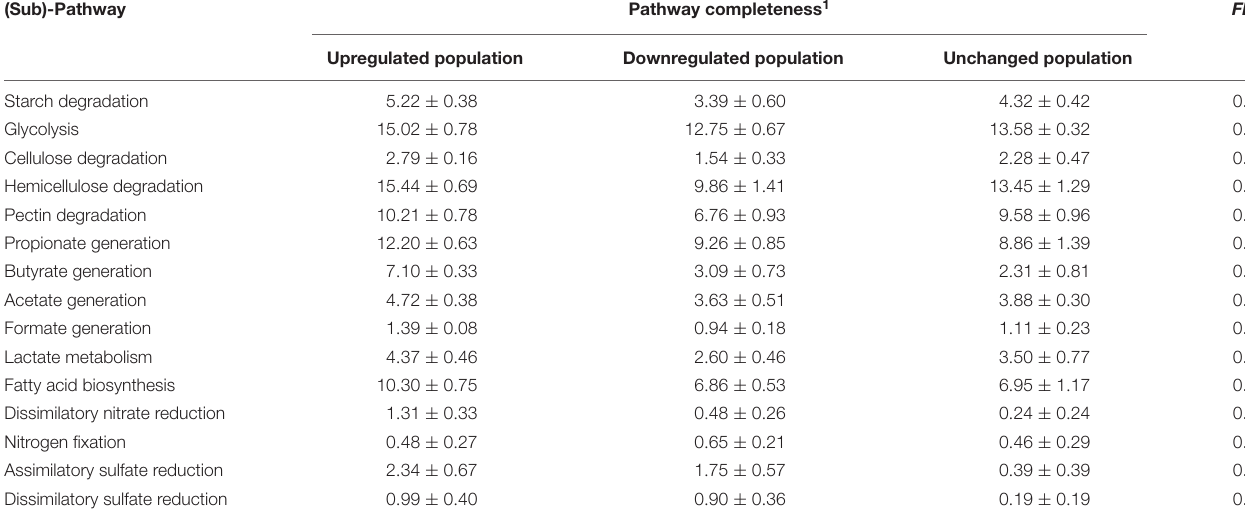
TABLE 5 | Comparison of completeness of pathways/sub-pathways among the populations of microbes with Ni-dependent enzyme genes.